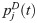
Comparison of different algorithms.Probability of default pjD(t) as a function of the relative equity loss hj(t) for different algorithms. The non-linear DebtRank interpolates between the Furfine algorithm and the non-linear DebtRank.